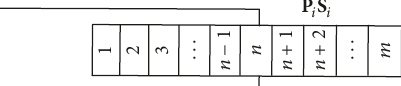
ments of driving limbs. q 1 ⋅ ⋅ ⋅ q 6 are the elastic displacements of the moving platform caused by elastic deformation of Figure 6: Unit of telescopic limb P 𝑖 S 𝑖 . driving limbs. M is total mass matrix of the mechanism, and